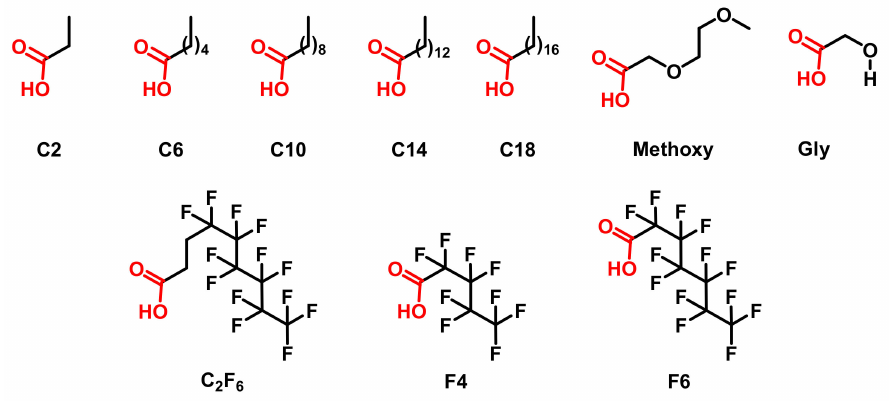
Figure 4. Acids used for post printing